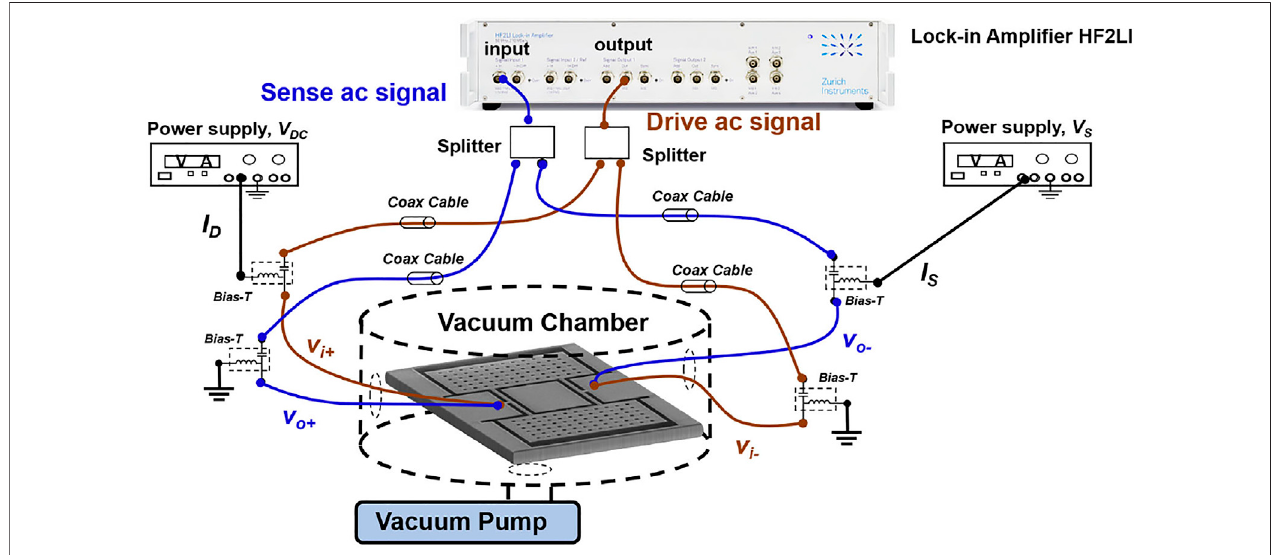
FIGURE 7 | Setup for characterization of a thermal piezoresistive oscillator (TPO) with a HF2LI lock-in ampli fi er with PLL.